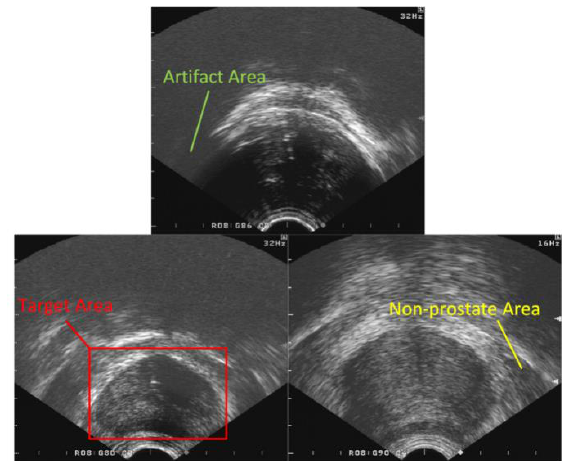
Figure 1. Target area, artifact area, and non-prostate area in transrectal ultrasound (TRUS) image.